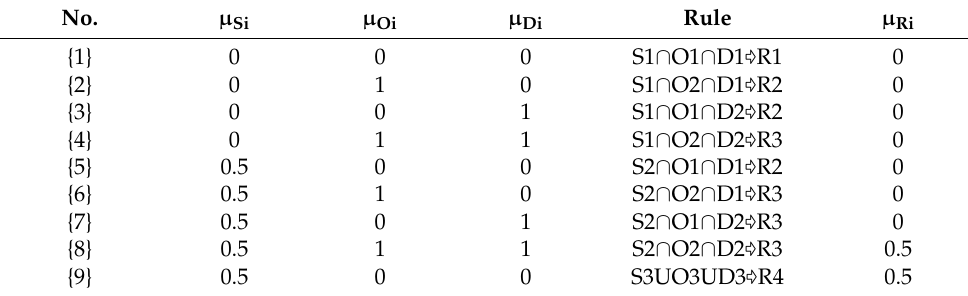
Table 5. Rule base for the composition